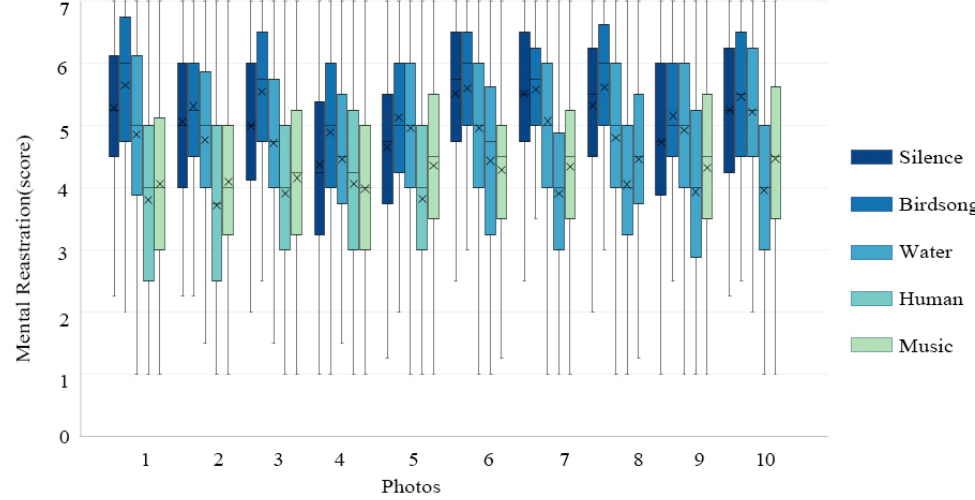
Figure 6. The restoration scores of visual stimuli (10 photos under ‘silence’) and audio-visual stimuli (combinations of ten photos and four sounds: ‘birdsong’, ‘water sound’, ‘human noise’, ‘mu- sic’).